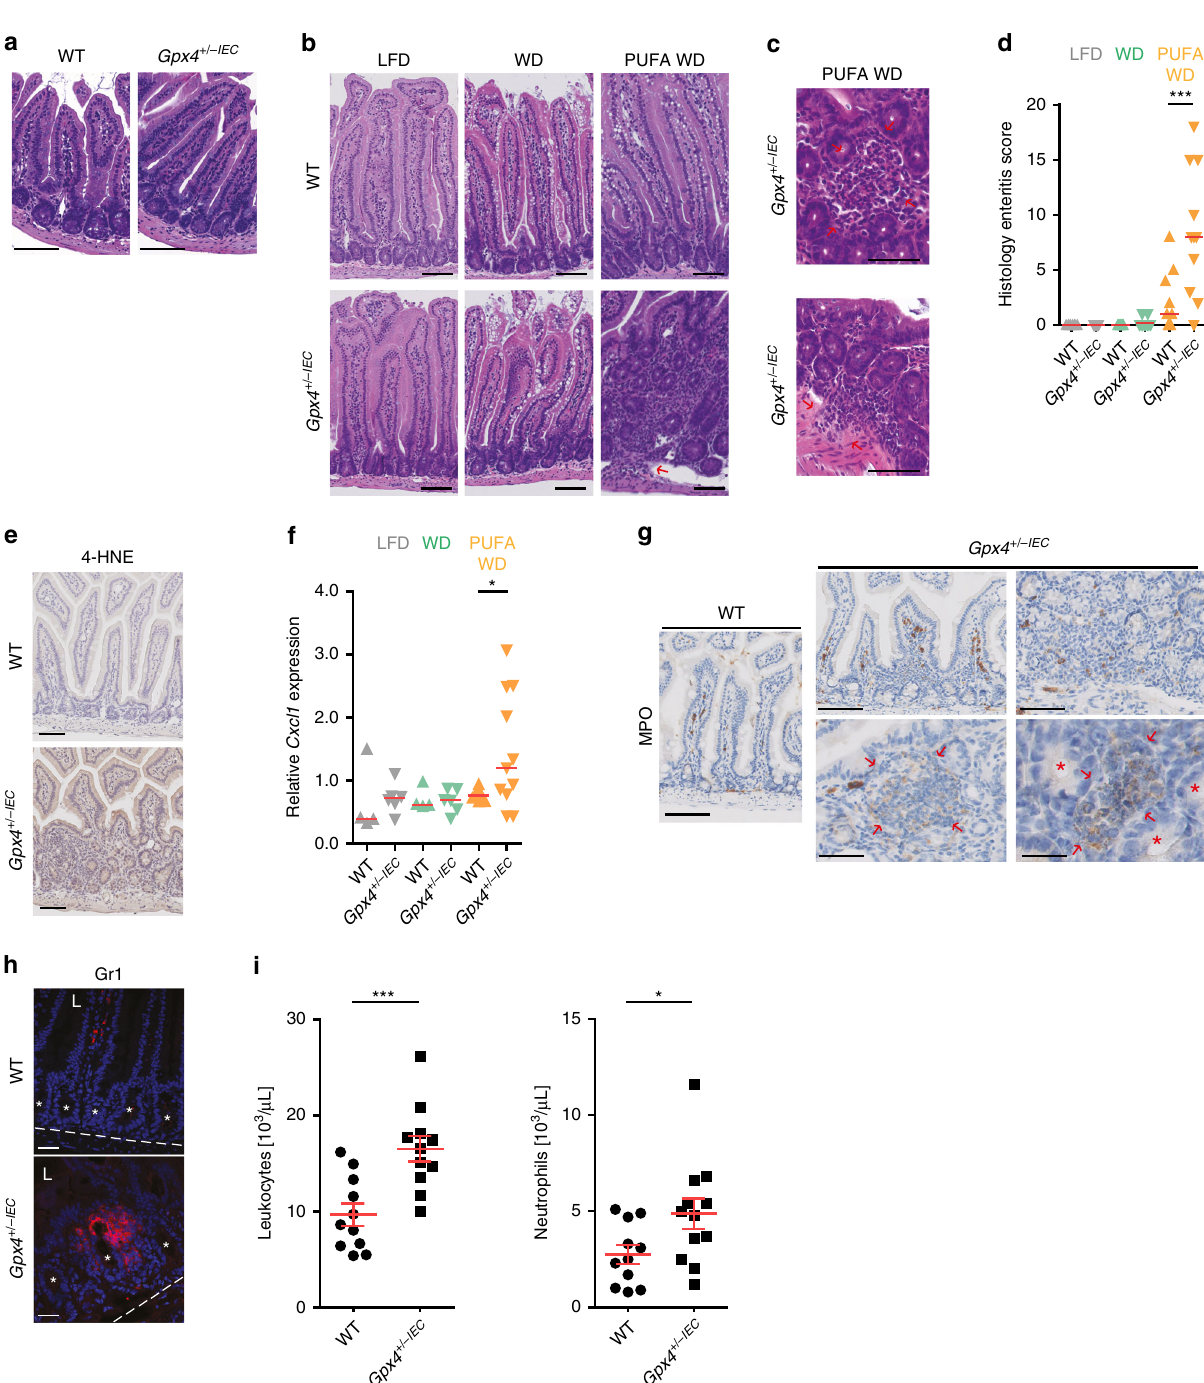
Fig. 5A-H) and Gpx4 de fi ciency induced ferroptosis of MODE-K